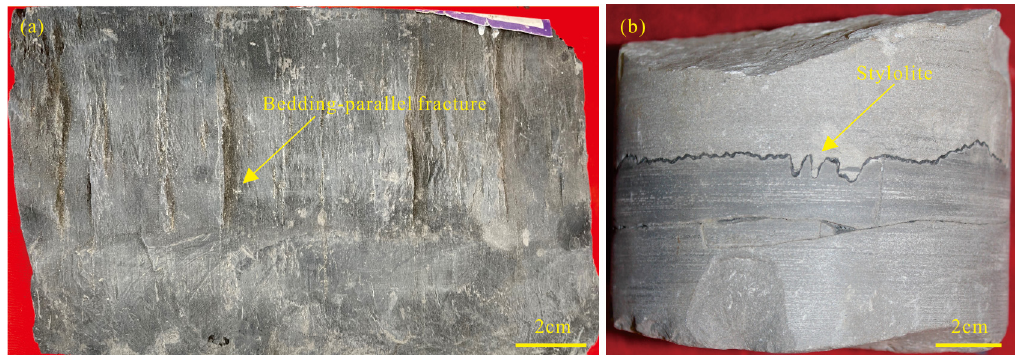
Figure 3. ( a ) Bedding-parallel fractures; ( b ) stylolite.